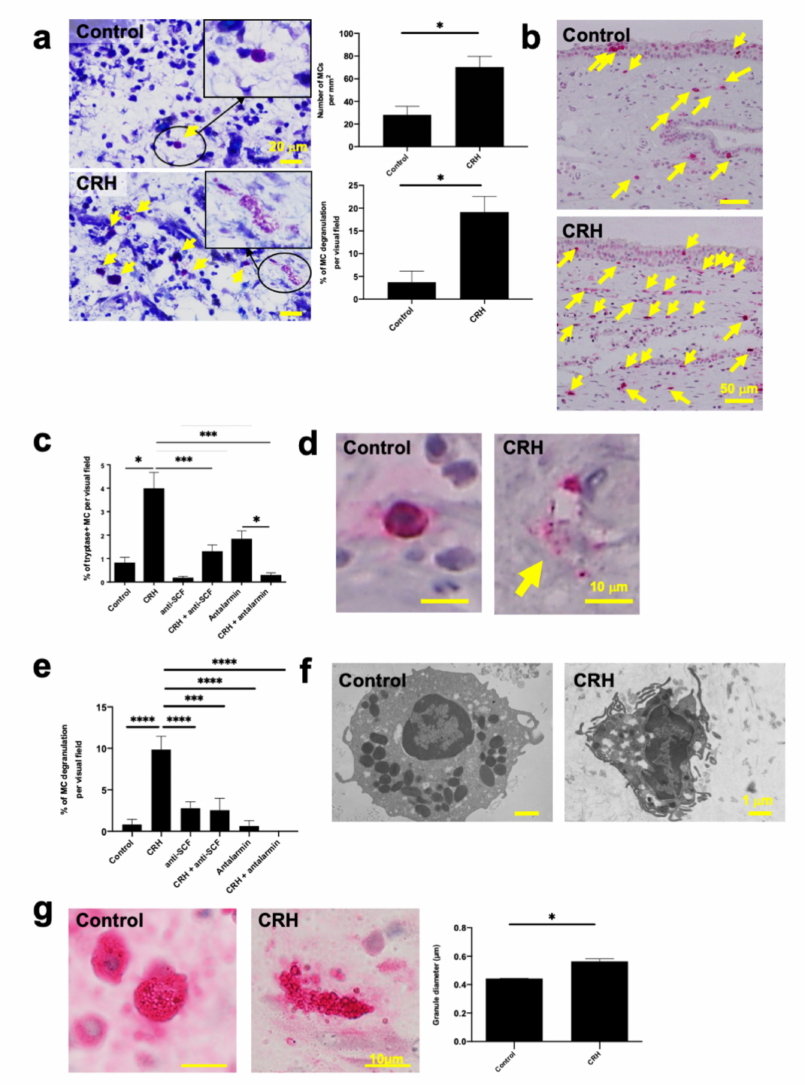
Figure 2. CRH increased tryptase+ hM-MC numbers and stimulated their degranulation. ( a ) Tolui- dine blue histochemistry with 1 day organ-cultured human NPs treated with vehicle or CRH (10 − 7 M). An arrow denotes hM-MCs in the lamina propria. Top, non-degranulated MCs in vehicle-treated NPs. Bottom, degranulated MCs in CRH-treated NPs. n = 5; scale bar = 20 µ m. ( b ) Tryptase im- munohistochemistry with 1 day organ-cultured human NPs treated with vehicle or CRH (10 − 7 M). Scale bar = 50 µ m. ( c ) Quantitative immunohistomorphometry of tryptase+ cells in the lamina propria of organ-cultured NPs with CRH, anti-SCF (stem cell factor neutralizing antibody; 1 µ g/mL), and/or antalarmin (10 − 6 M); n = 6. ( d ) Tryptase immunohistochemistry. An arrow denotes MC degranulation induced by CRH. Scale bar = 10 µ m. ( e ) Percentage of degranulated MCs treated with CRH, anti-SCF (1 µ g/mL), and/or antalarmin (10 − 6 M) analyzed by tryptase immunohistochemistry; n = 6. ( f ) Electron microscope images of CRH-induced MC degranulation. Scale bar = 1 µ m. ( g ) Di- ameter of tryptase+ hM-MC granules; n = 6; scale bar = 10 µ m. Error bars indicate SEM. * p < 0.05, *** p < 0.001, **** p < 0.0001. MC, mast cell; hM-MCs, human nasal mucosa MCs; NPs, nasal polyps; CRH, corticotropin-releasing hormone; anti-SCF, stem cell factor neutralizing